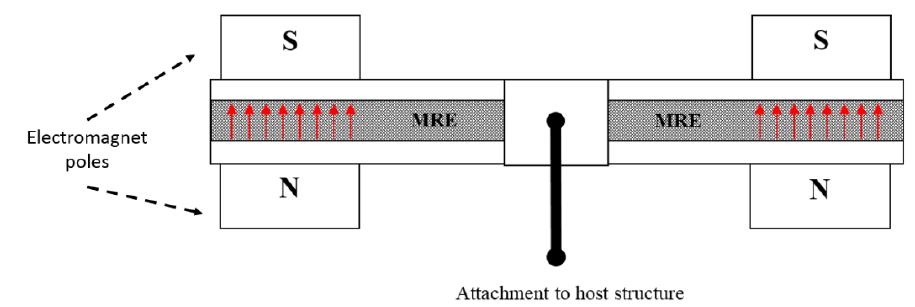
Figure 1. Schematic design of the proposed magnetorheological elastomer (MRE)-based sandwich beam type adaptive tuned vibration absorber.